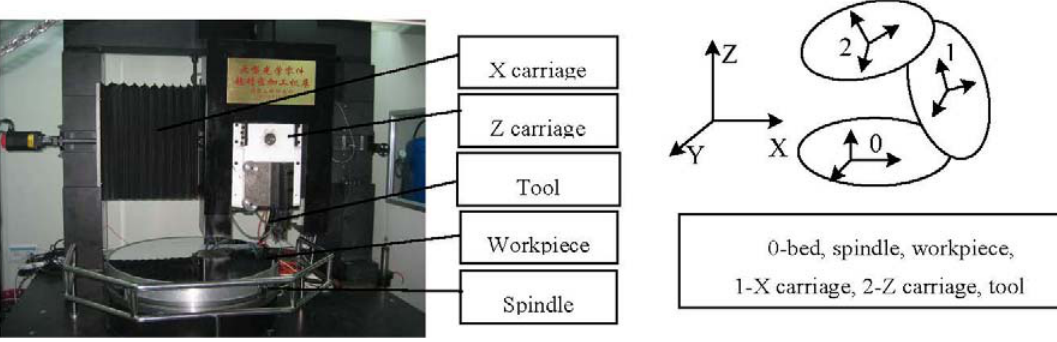
Figure 1. The researched machine tool. ( a ) The structure; ( b ) The